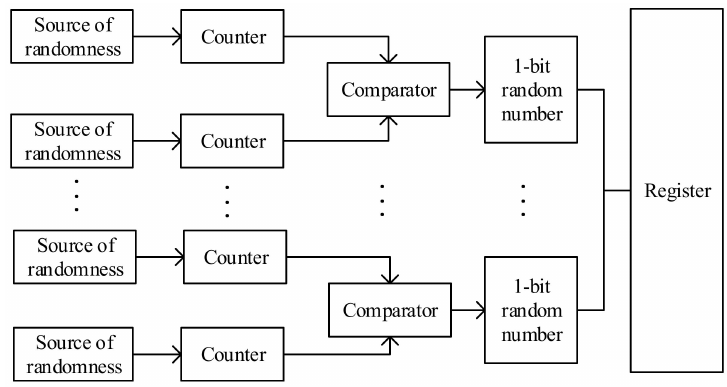
Figure 3. Block diagram of TRNG